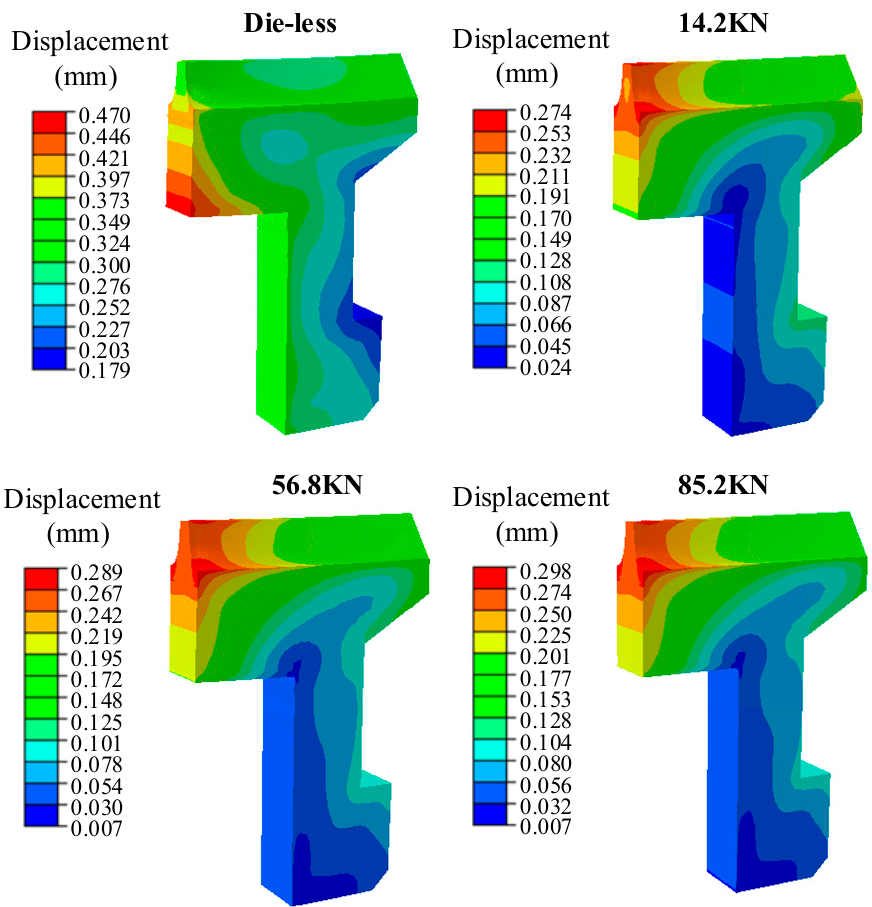
Figure 15. Deformation of Gear After Quenching Under Different Loads.